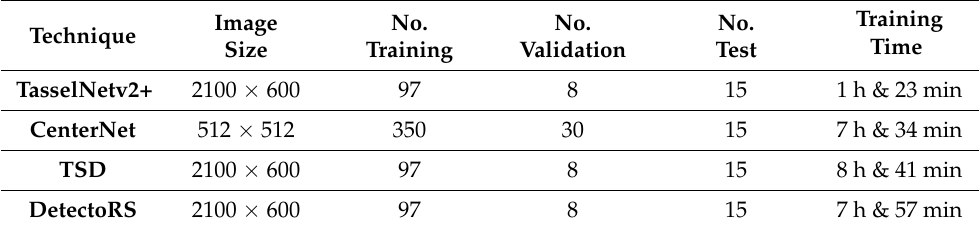
Table 2. Training and testing